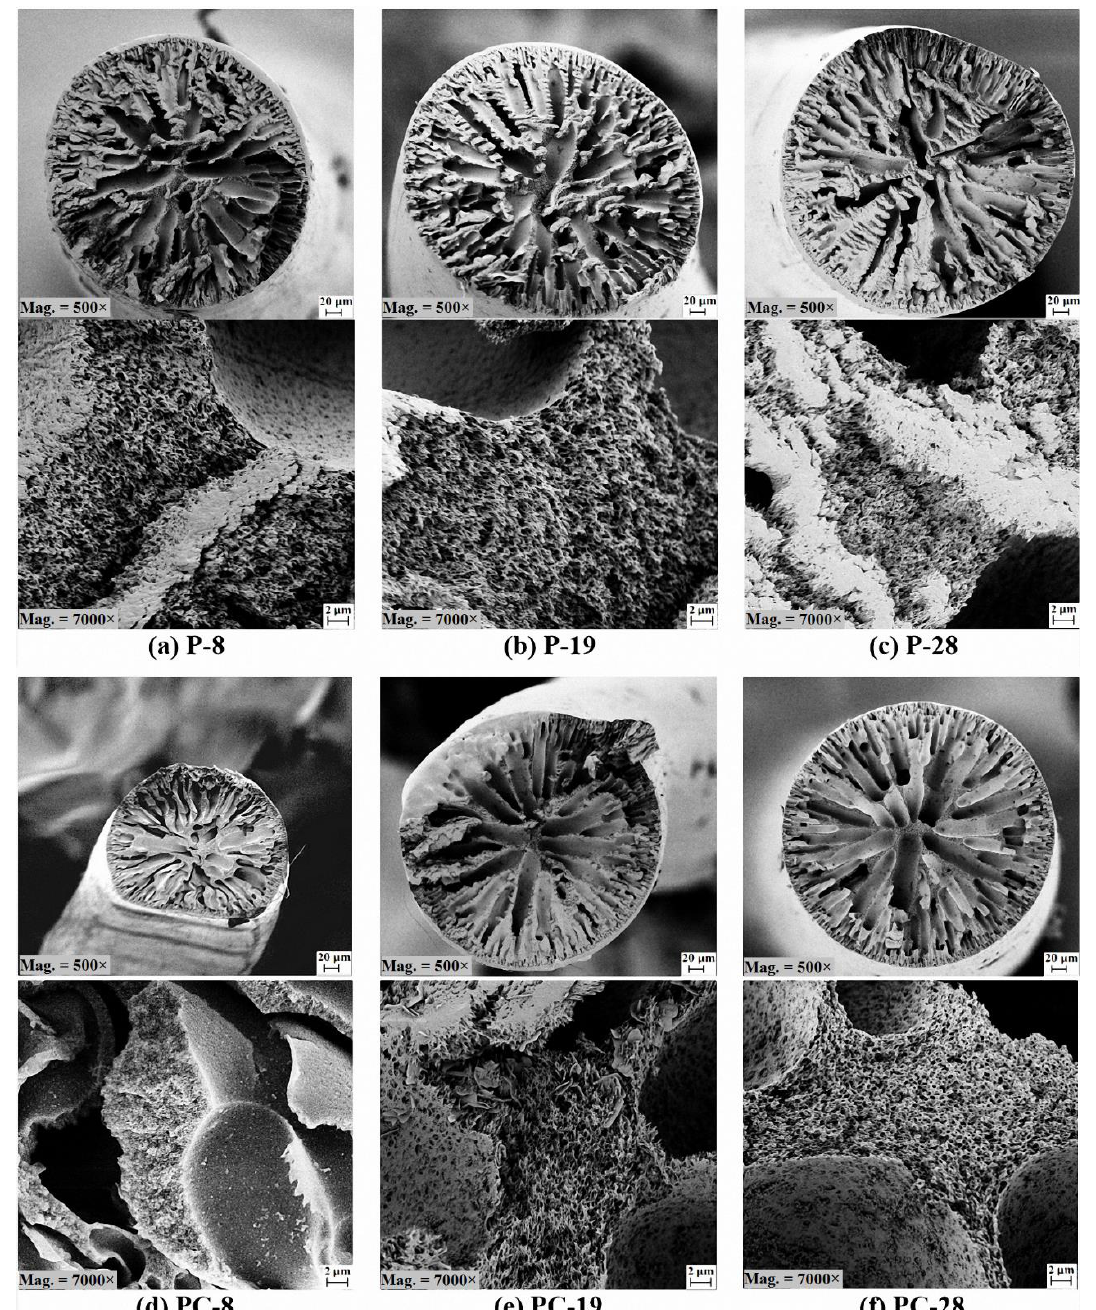
Figure 3. FESEM images from cross section and internal morphology of PAN and PAN / CNT fibers spun with different shear rates at magnifications of 500× and 7000×.